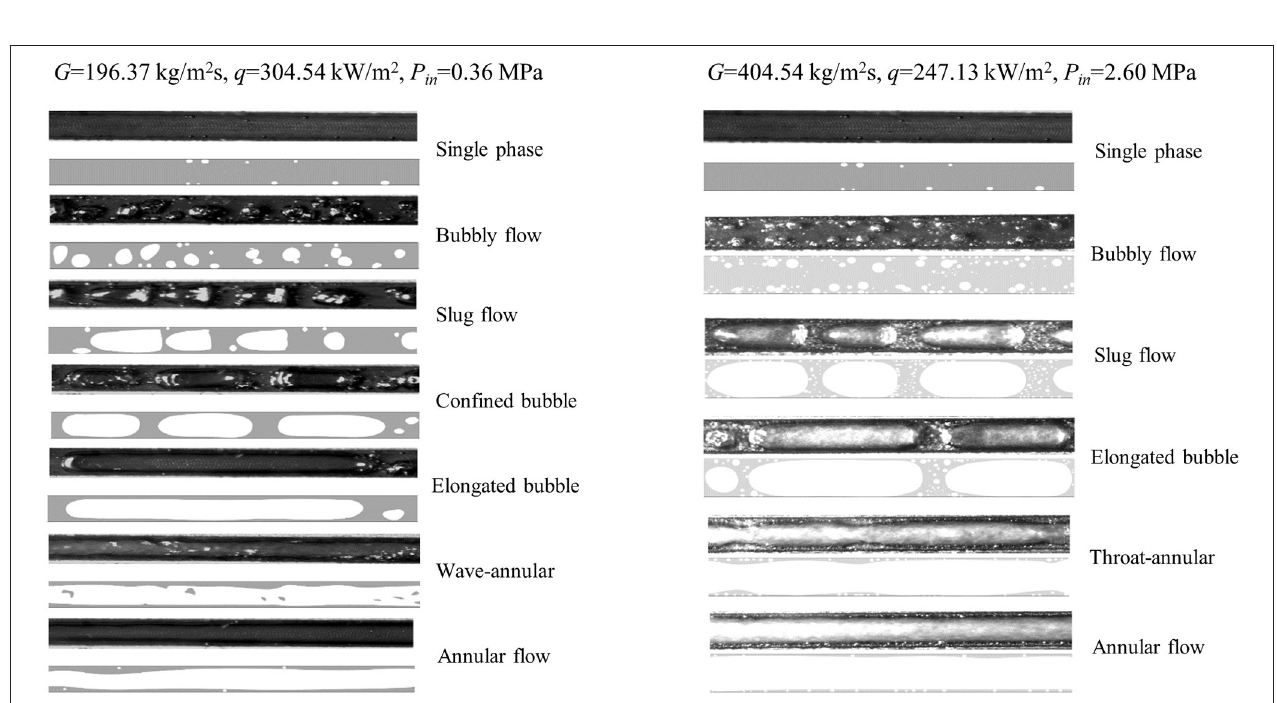
Frontiers in Energy Research |